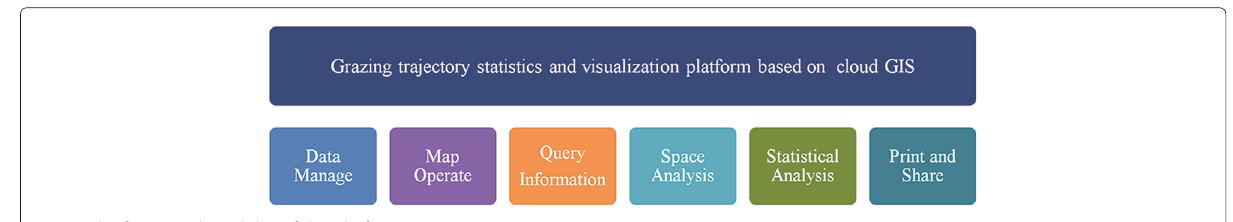
Fig. 1 The functional modules of the